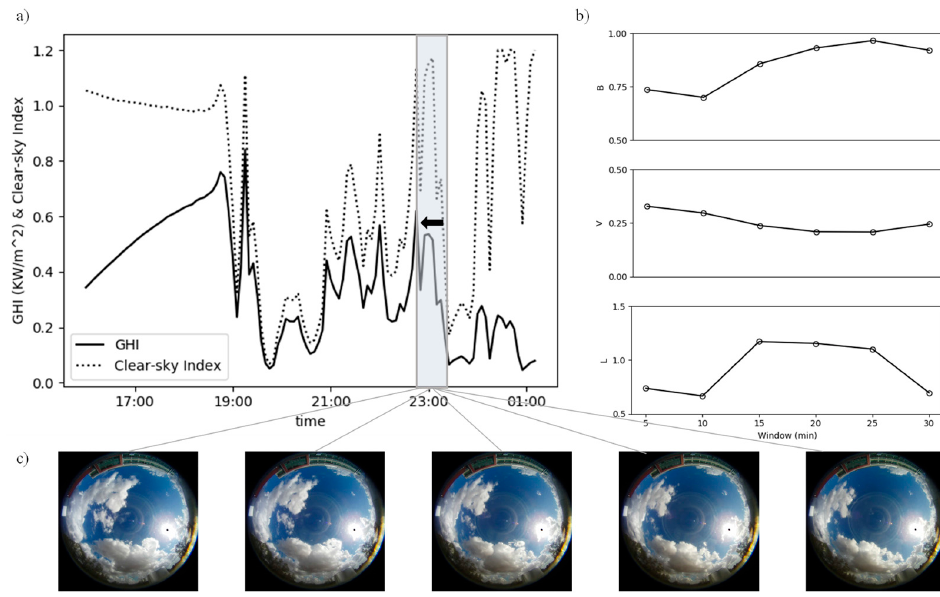
Figure 3. Five min average irradiance data from “2016-10-02 14:35:00 PST” to “2016-10-03 00:25:00 PST”. ( a ): target GHI and corresponding clear-sky index; ( b ): backward irradiance features of different horizon windows; and ( c ): backward sky images.